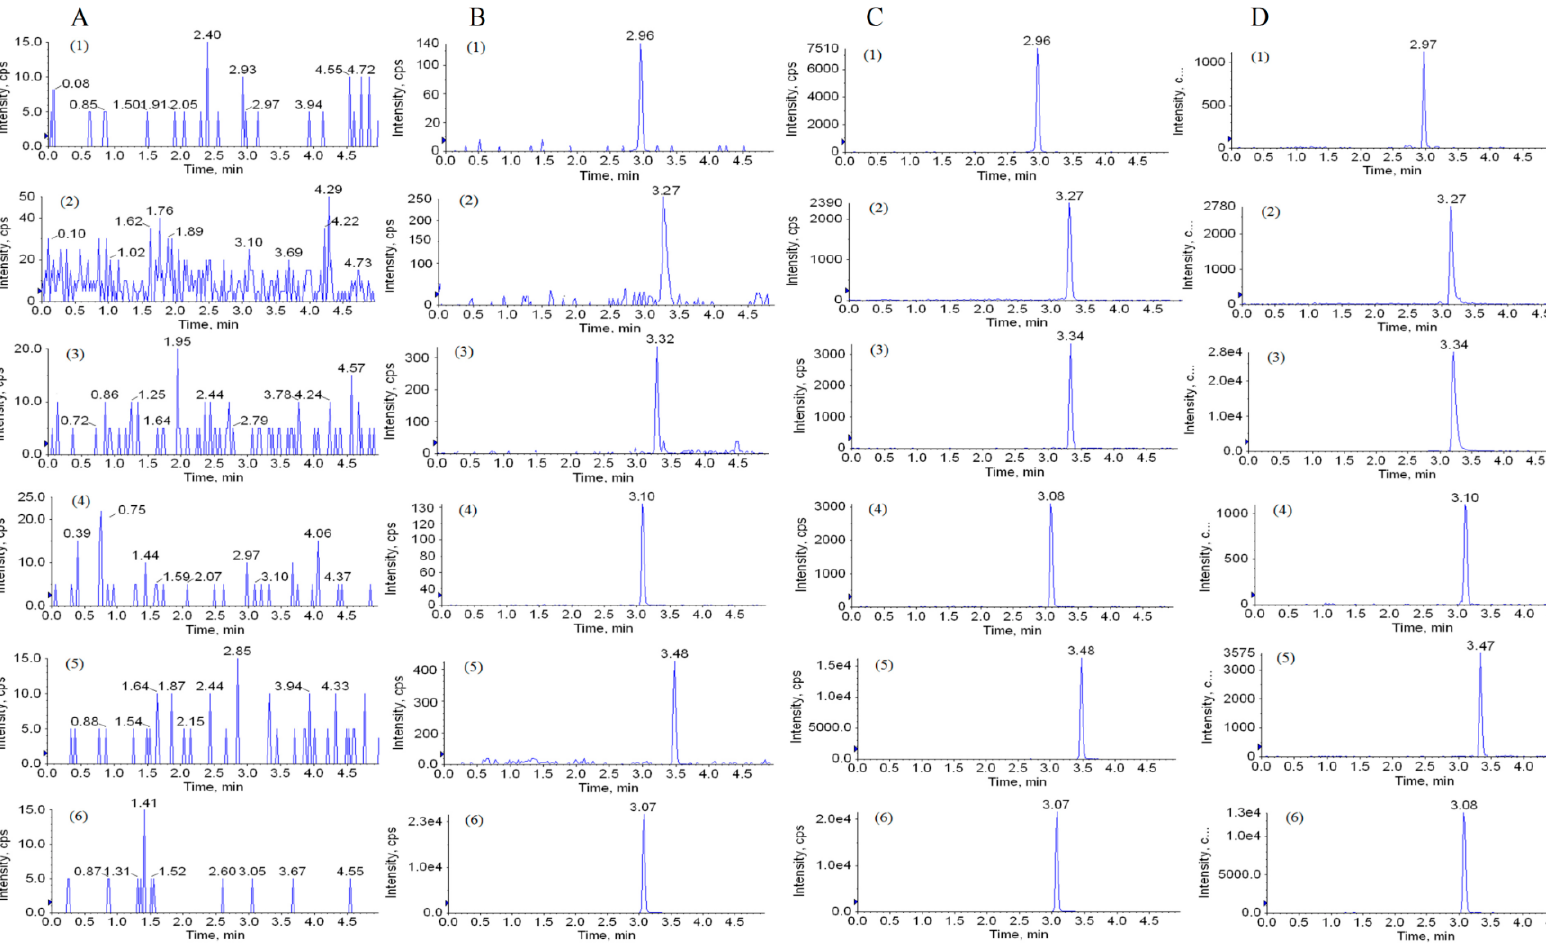
Figure 2. Typical MRM chromatograms of aesculin (1), aesculetin (2), fraxetin (3), fraxin (4), polydatsin (5), puerarin (6). Blank plasma from six beagle dogs ( A ); spiked plasma samples with the analytes and IS at LLOQ level ( B ); spiked plasma samples with the analytes and IS at QCM ( C ); plasma samples from beagle dog 1 h after oral administration of the extract of L. palustre ( D ).